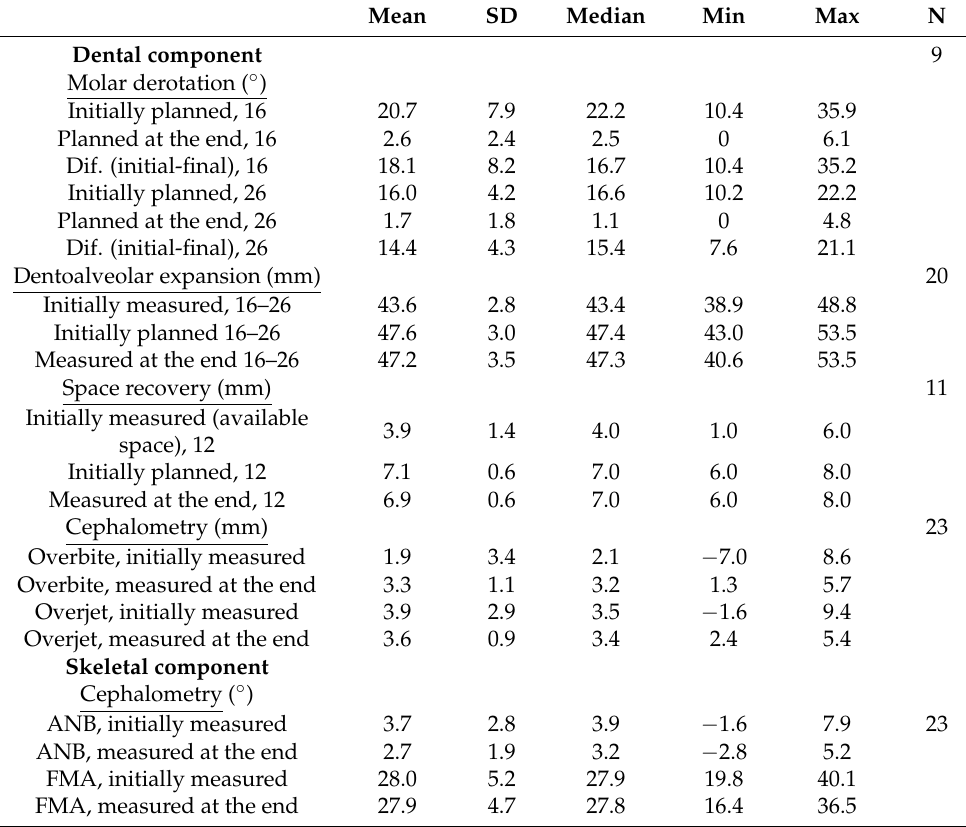
Table 4. Descriptive statistics regarding derotation, dentoalveolar expansion, and space recovery mea- surements for the teeth presenting more prominent movements to achieve, as well as cephalometry metrics for all